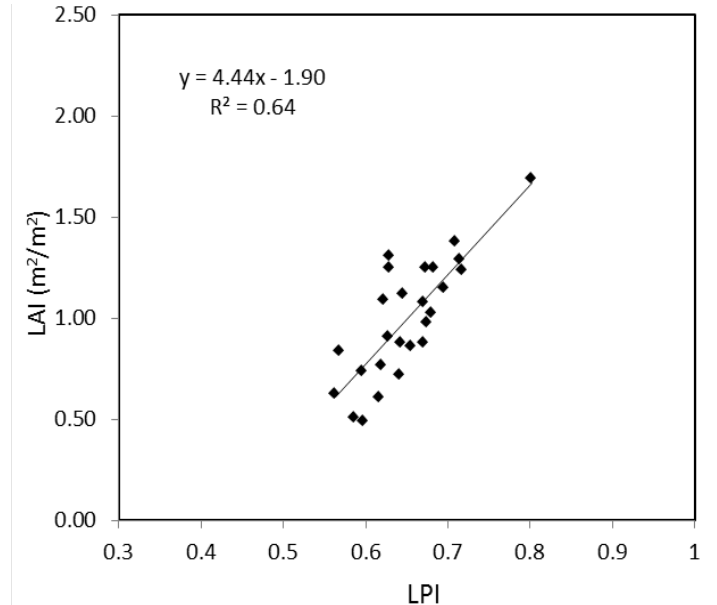
Figure 9. Relationship between observed effective (LAIe) and the laser penetration index (LPI) (1) obtained from ALS data.